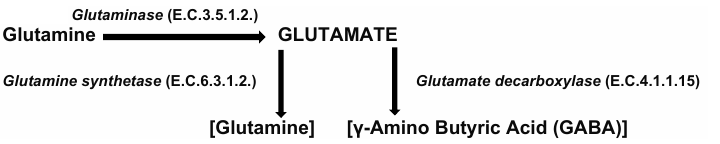
Figure 1. The biosynthesis production process, a non-essential amino acid glutamate is readily decarboxylated to GABA, catalysed by an enzyme glutamate decarboxylase (GAD), EC 4.1.1.15.